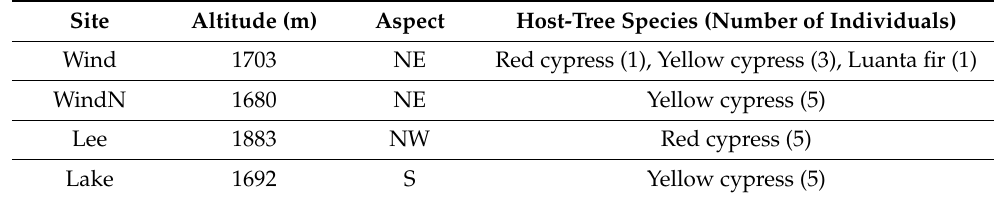
Table 1. Description of the sites.